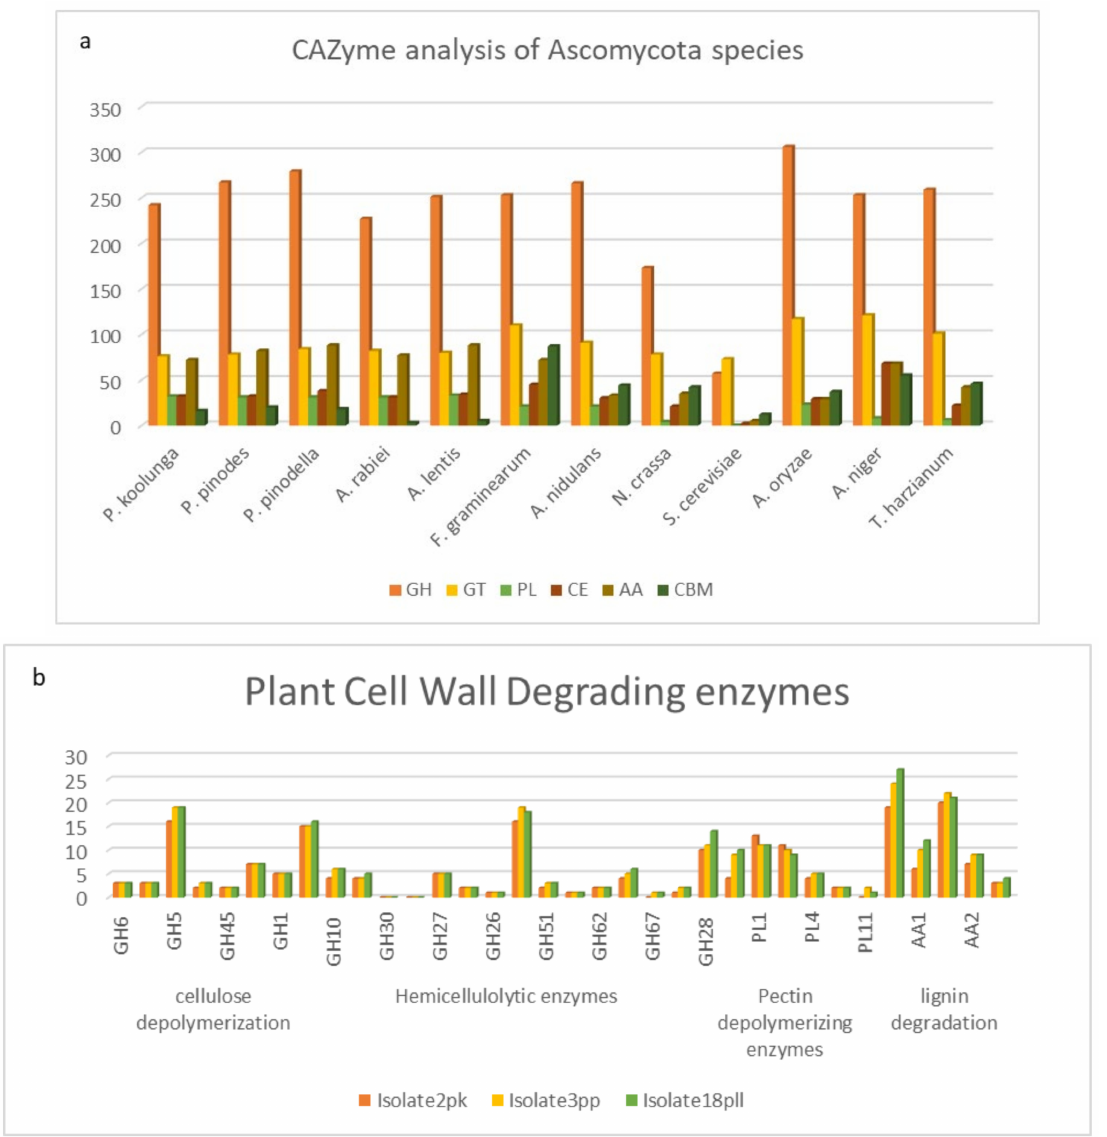
Figure 6. AB CAZyme analysis. ( a ) CAZyme analysis profile of Ascomycota species; ( b ) AB Plant- cell-wall-degrading CAZyme analysis (GH- glycoside hydrolases, GT- glycosyl transferases, PLs- polysaccharide lyases, CEs- carbohydrate esterases, AAs- auxiliary activities and CBMs- carbohydrate- binding